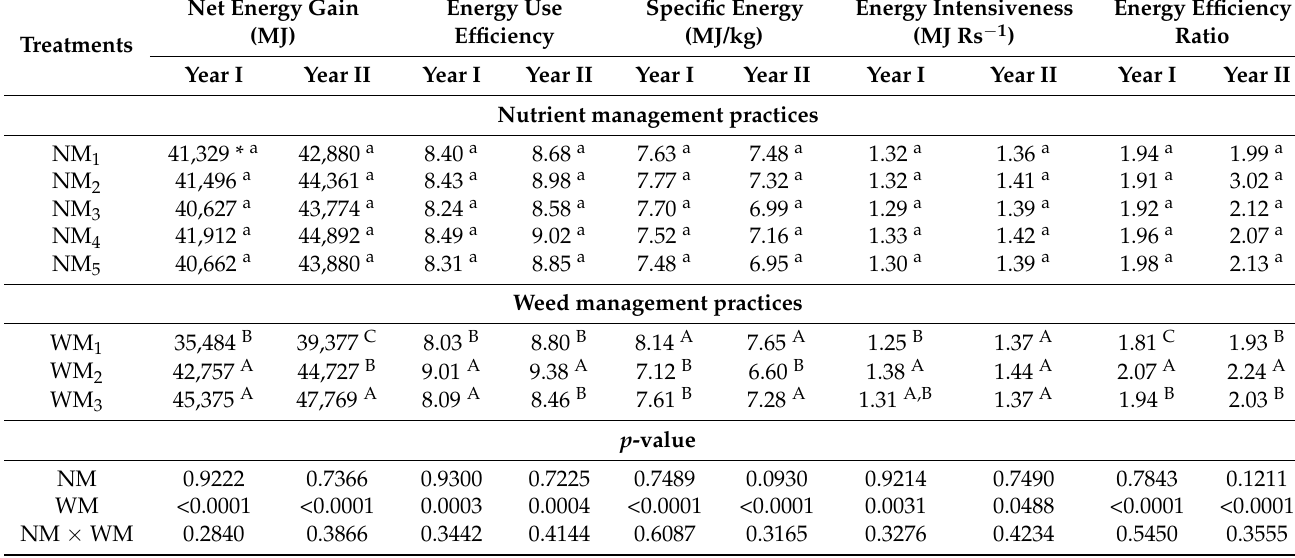
Table 7. Energy indicator in green gram under rice–maize–green gram cropping